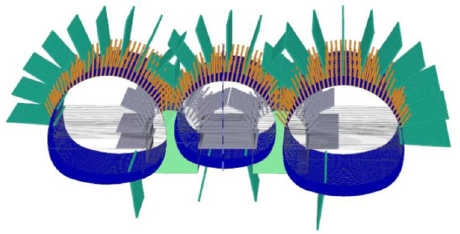
Figure 8. The prototype of the guide pit and the triple adjacent tunnels.